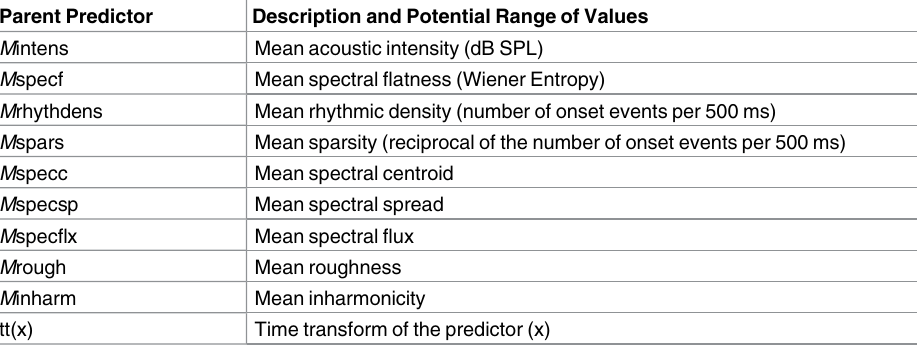
Table 3. Description of predictors used in cox hazard models of perceived